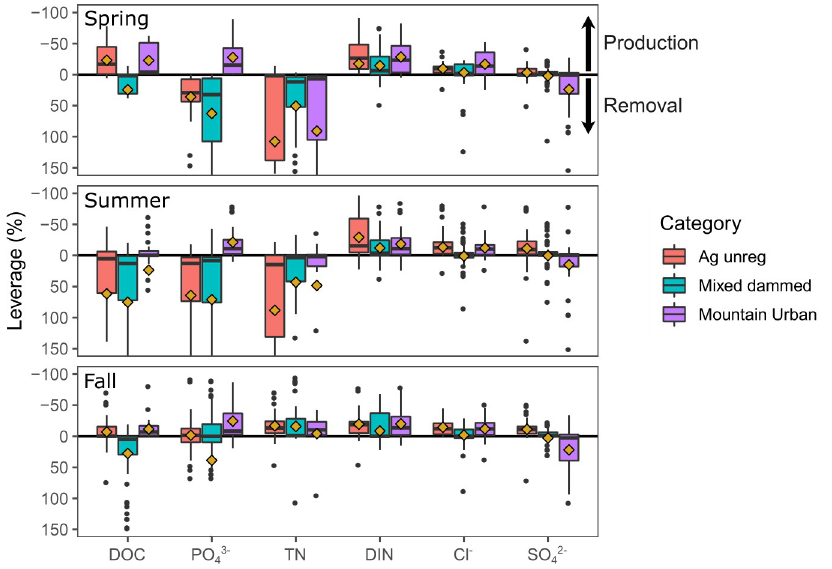
Fig 5. Distribution of leverage values show prevailing watershed production or removal for solutes across seasons. Diamonds represent the mean leverage value for each subwatershed category. The horizontal black line at y = 0 represents a neutral mass balance. Diamonds that are above the black line indicate solute production and diamonds below the black line indicate solute removal within the surface water network.